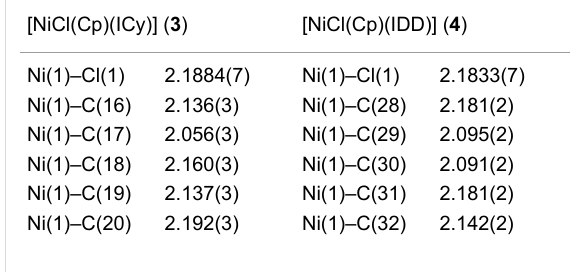
Table 2: Selected bond distances (units